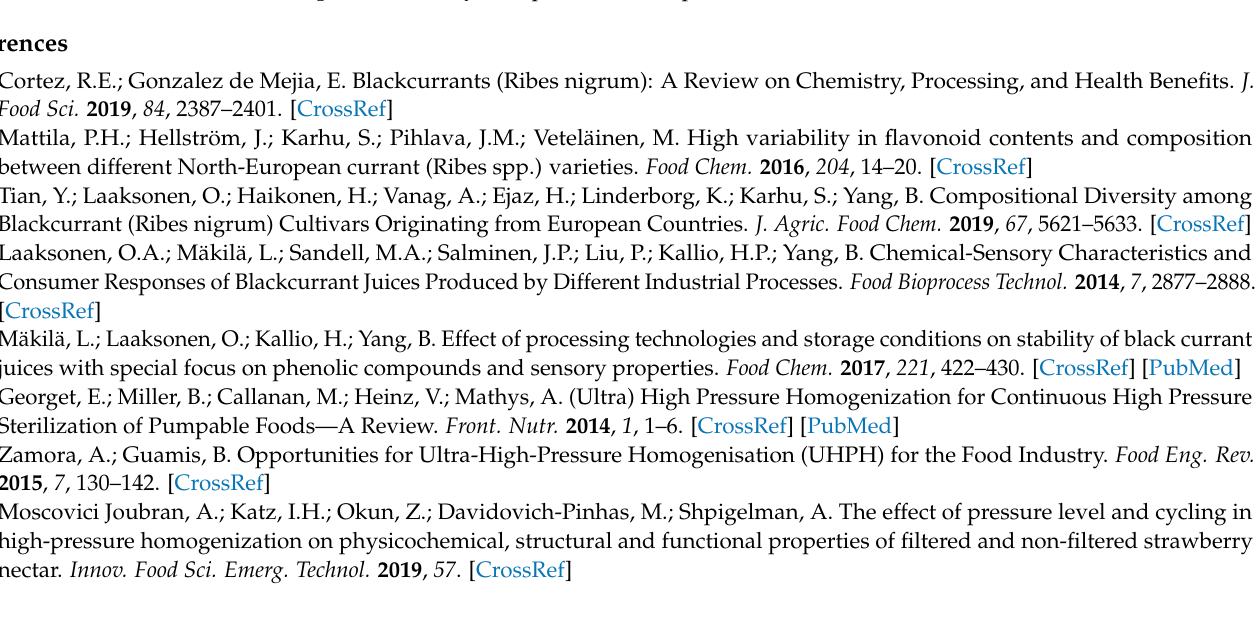
Supplementary Materials: Table S1: L*, a*, and b* colour values of cloudy blackcurrant juice samples treated with high-pressure homogenization or